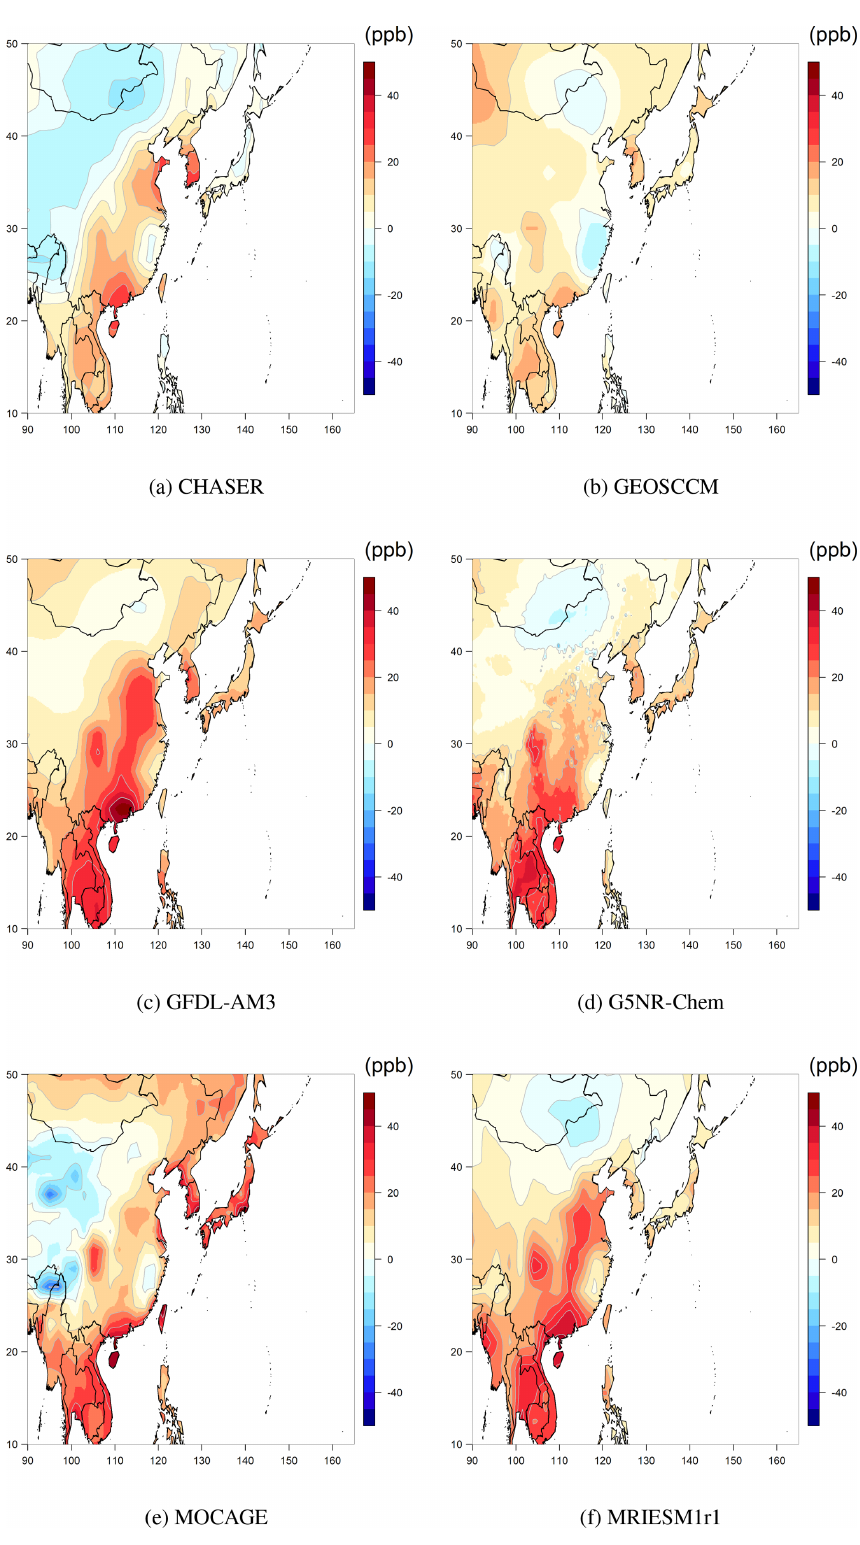
Figure 6. Spatial distributions of the ozone metric in east Asia from each model minus spatially interpolated